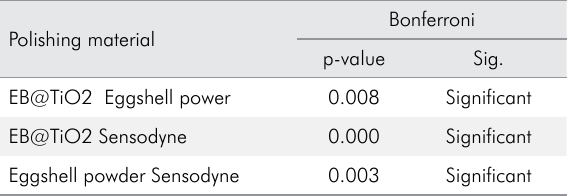
Table 2. Bonferroni multiple comparison